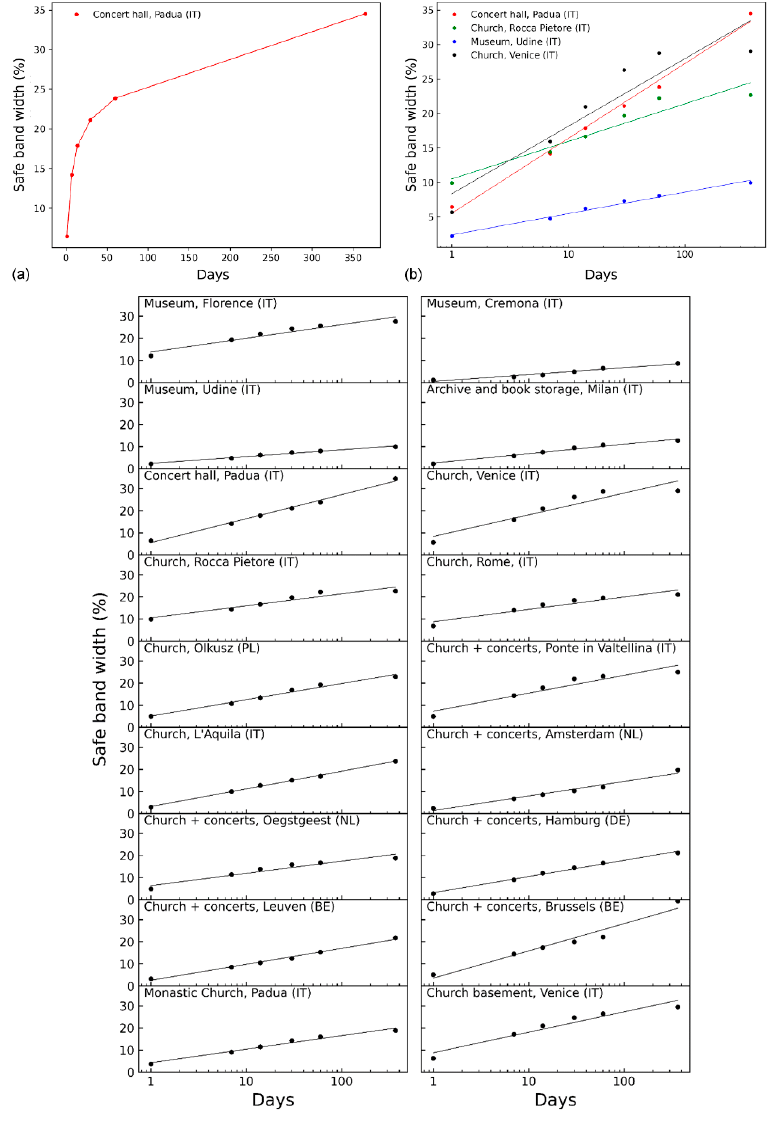
Figure 5. The safe band width is logarithmically related to the time window. ( a ) The example of a case study in a linear coordinate paper. The plot is logarithmic. ( b ) In semi-logarithmic paper (i.e., days in logarithmic scale) the plots become straight-lines. The four case studies used as detailed examples. ( c ) The whole set of case